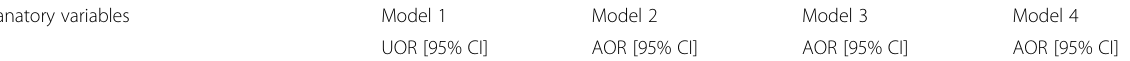
Table 3 Effects of biomass fuel use, residential factors, and mother and child characteristics on respiratory symptoms based on sequential multiple logistic regression models